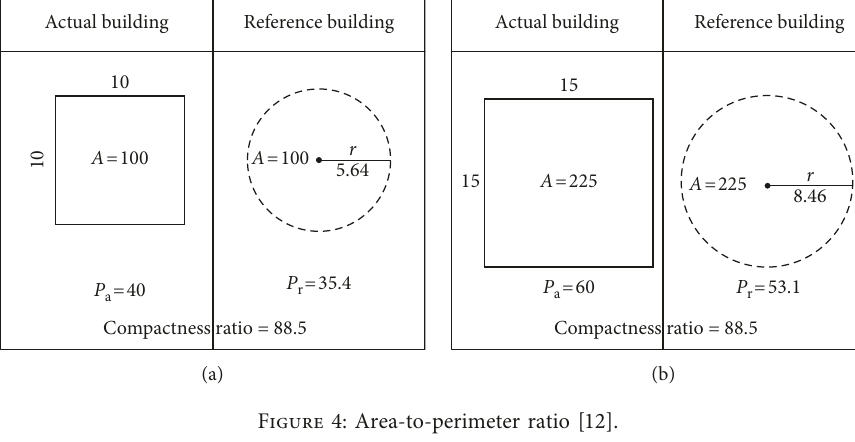
Figure 4: Area-to-perimeter ratio [12].